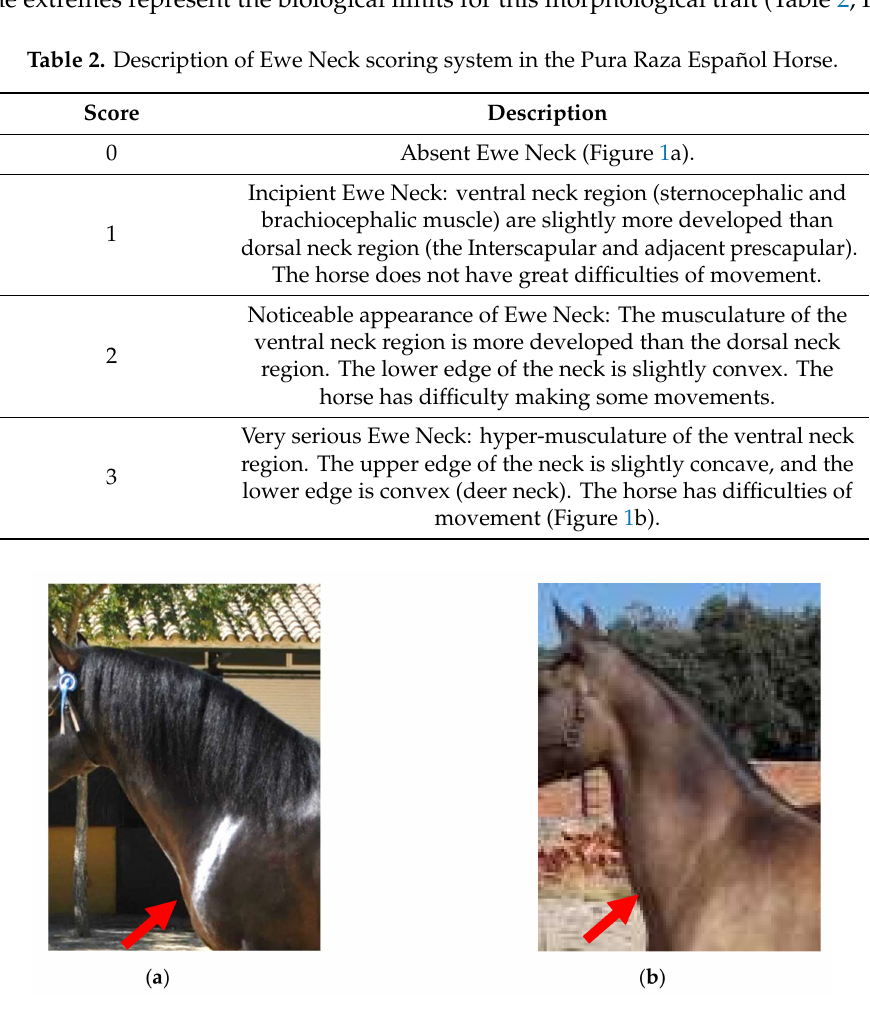
Figure 1. Ewe Neck in Pura Raza Español horse: ( a ) the morphological defect not present and ( b ) morphological defect Ewe